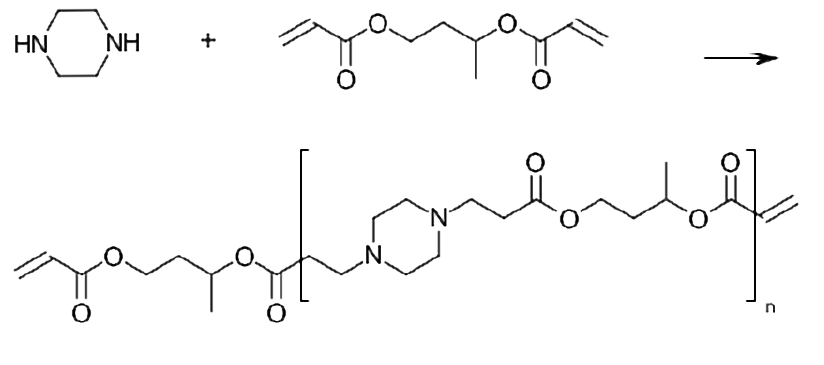
Figure 1. Synthesis of 1,3-butanediol diacrylate (1,3-BDDA) and piperazine (PIP). The diamine nitrogen breaks the double bond on the diacrylate and forms a secondary ( β -amino